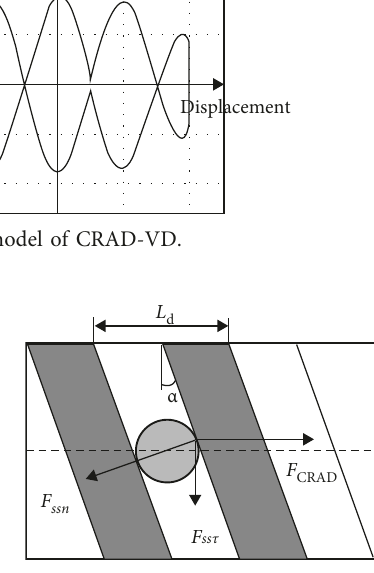
Figure 4: Force analysis diagram of the ball screw.